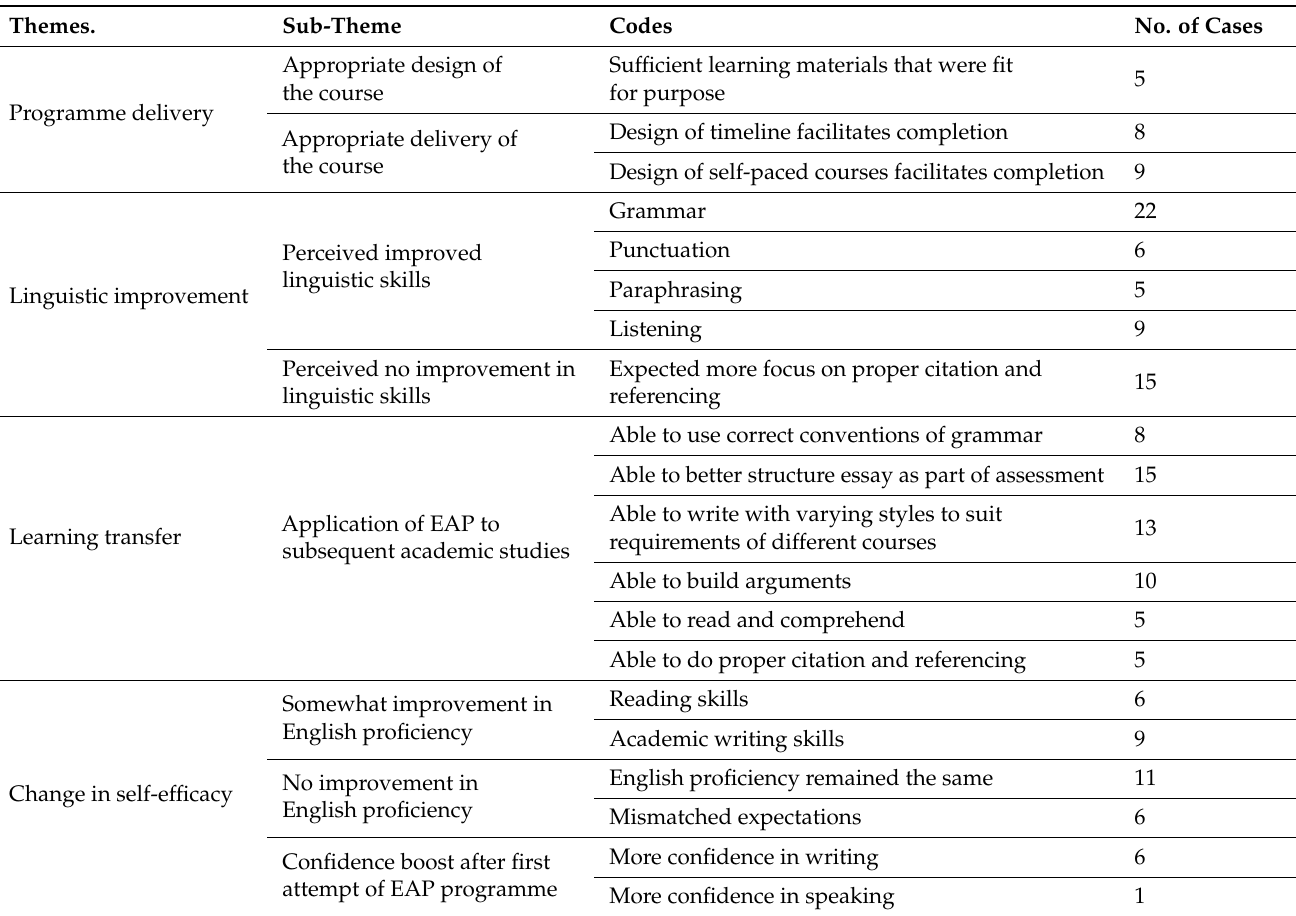
Table A2. Summary table on the number of cases for each